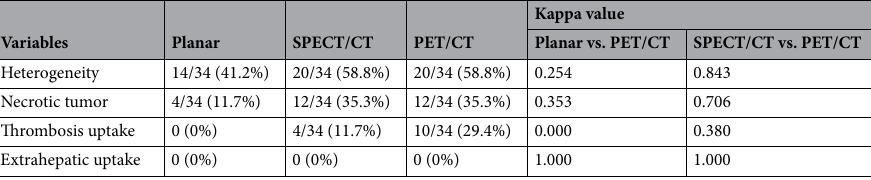
Table 2. Image characteristics and measurements of 99m Tc-MAA planar image, SPECT/CT and 90 Y PET/CT.